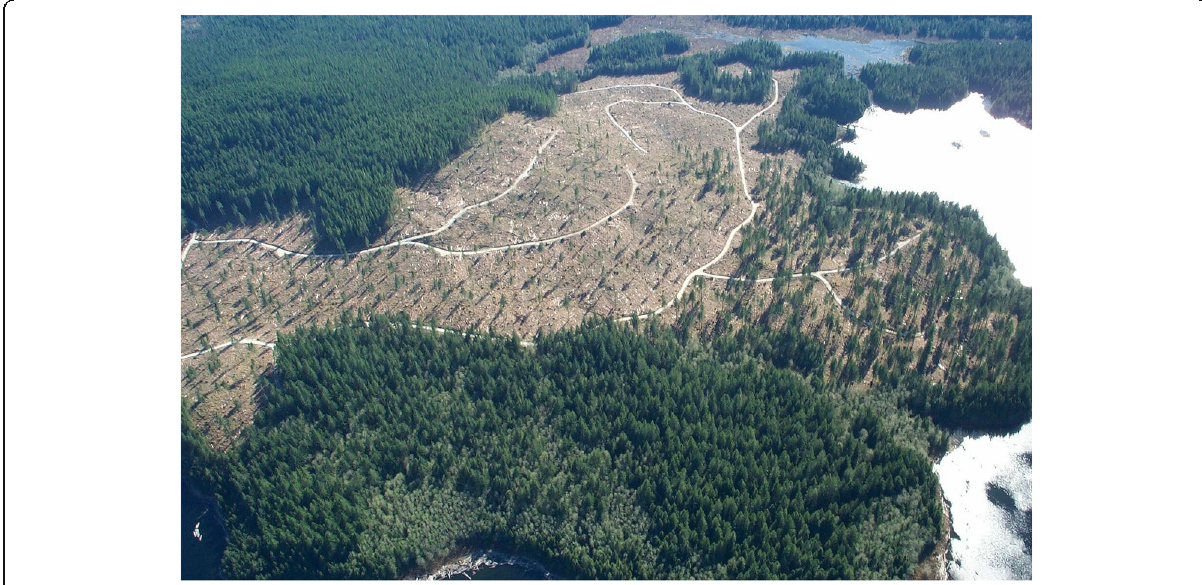
Fig. 3 VRAM dispersed retention experiment at Horseshoe Lake near Powell River, BC. Treatments are uncut (lower), clearcut (upper center) and 10%, 5%, 30% retention (left to right, middle). Photo by W.J.